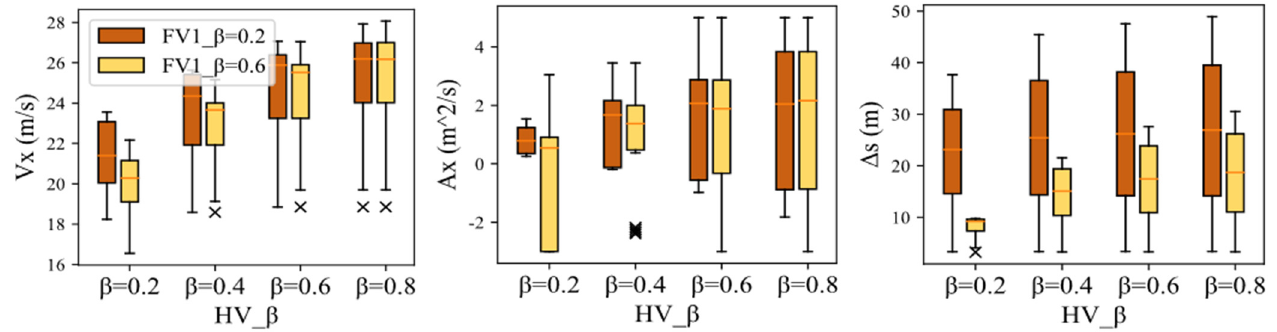
Δ S in Scenario A. V , A , and x x